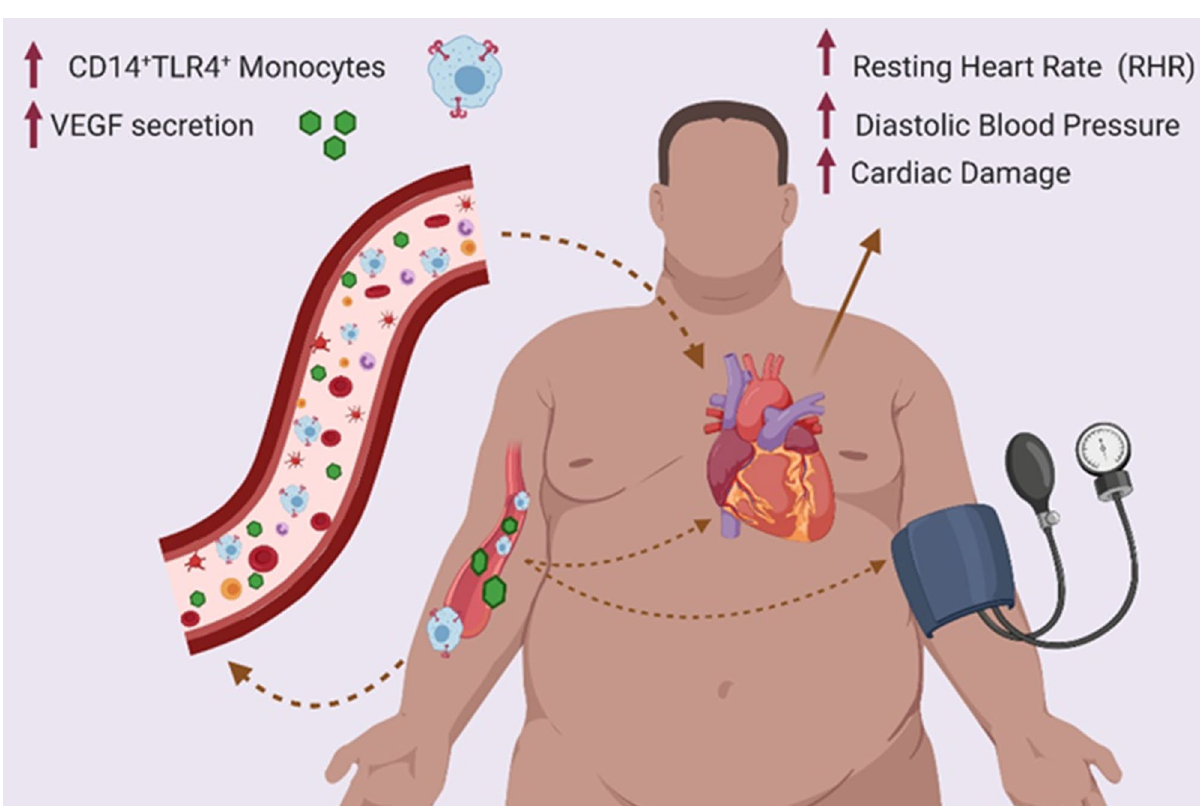
Figure 4. Schematic illustration. Elevated RHR in healthy obese individuals is associated with CD14 + TLR4 + monocytes and circulatory VEGF levels. Tracking and monitoring changes in the RHR could be used as a useful and non-invasive clinical indicator to identify the obese individuals at risk of sub-clinical inflammation and ensuing cardiovascular events. The figure was created using